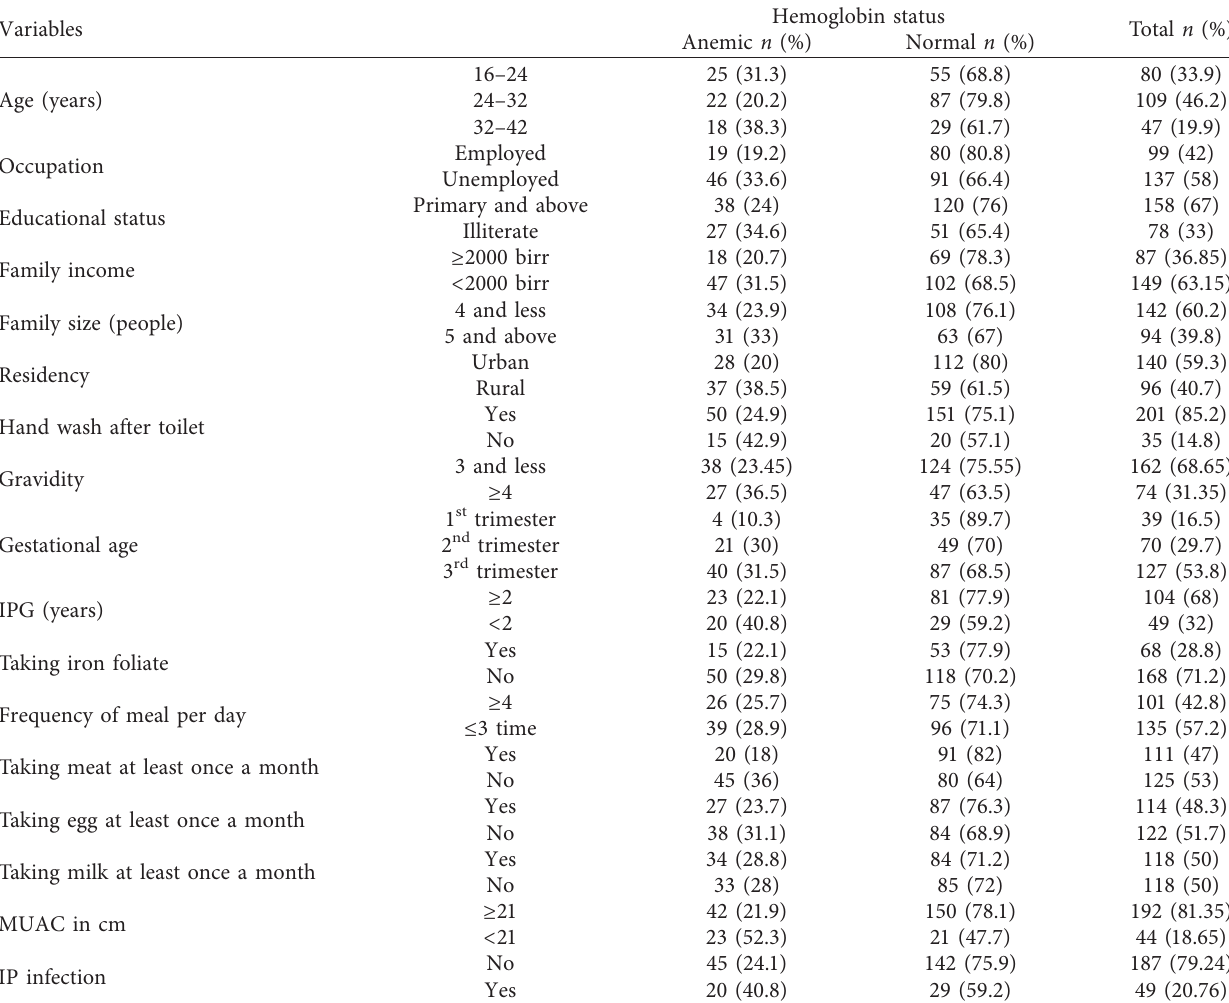
Table 3: Anemia and other related factors among study participants in Kulito Health Center, SNNPR, Ethiopia, 2018 ( n �